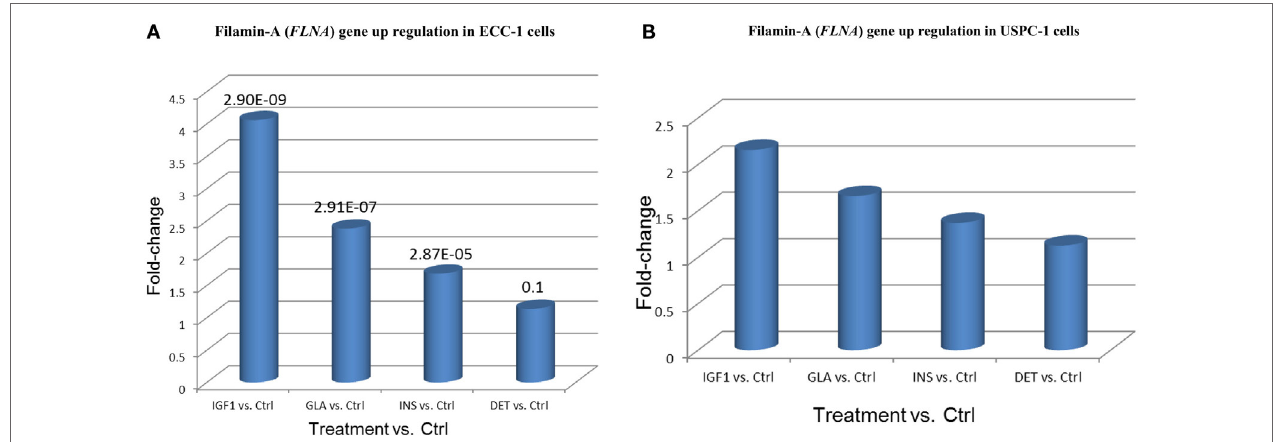
FigUre 10 | Filamin-A ( FLNA ) gene upregulation in (a) ECC-1 and (b) USPC-1 cells. Starved ECC-1 (a) and USPC-1 (b) cells were treated with IGF1, glargine, insulin, or detemir at a dose of 8.6 nM for 24 h, after which, RNA was prepared and FLNA gene expression was measured as described in Section “Materials and Methods.” Results are expressed as fold-changes compared to untreated